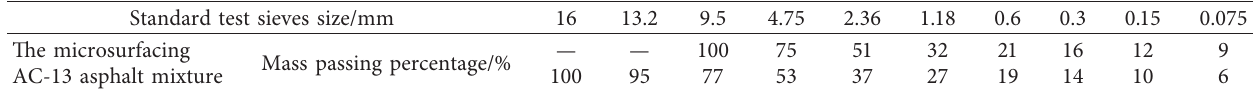
Table 4: The gradation of microsurfacing and AC-13 asphalt